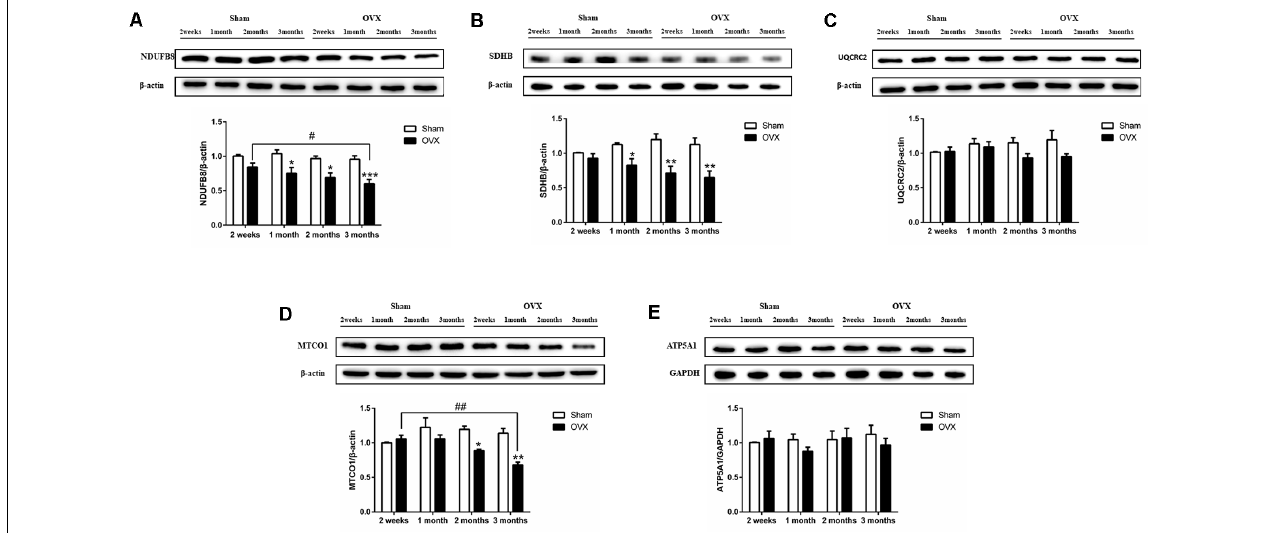
FIGURE 4 | Levels of the mitochondrial function proteins (A) NDUFB8, (B) SDHB, (C) UQCRC2, (D) MTCO1, (E) ATP5A1 in the hippocampus of sham-operated (Sham) and ovariectomized (OVX) mice. Bars represent mean values ± standard error of the mean (SEM). * p < 0.05 ** p < 0.01, *** p < 0.001 compared with the Sham mice at the same timepoint; # p < 0.05, ## p < 0.01 compared with the 2 weeks OVX mice ( n =